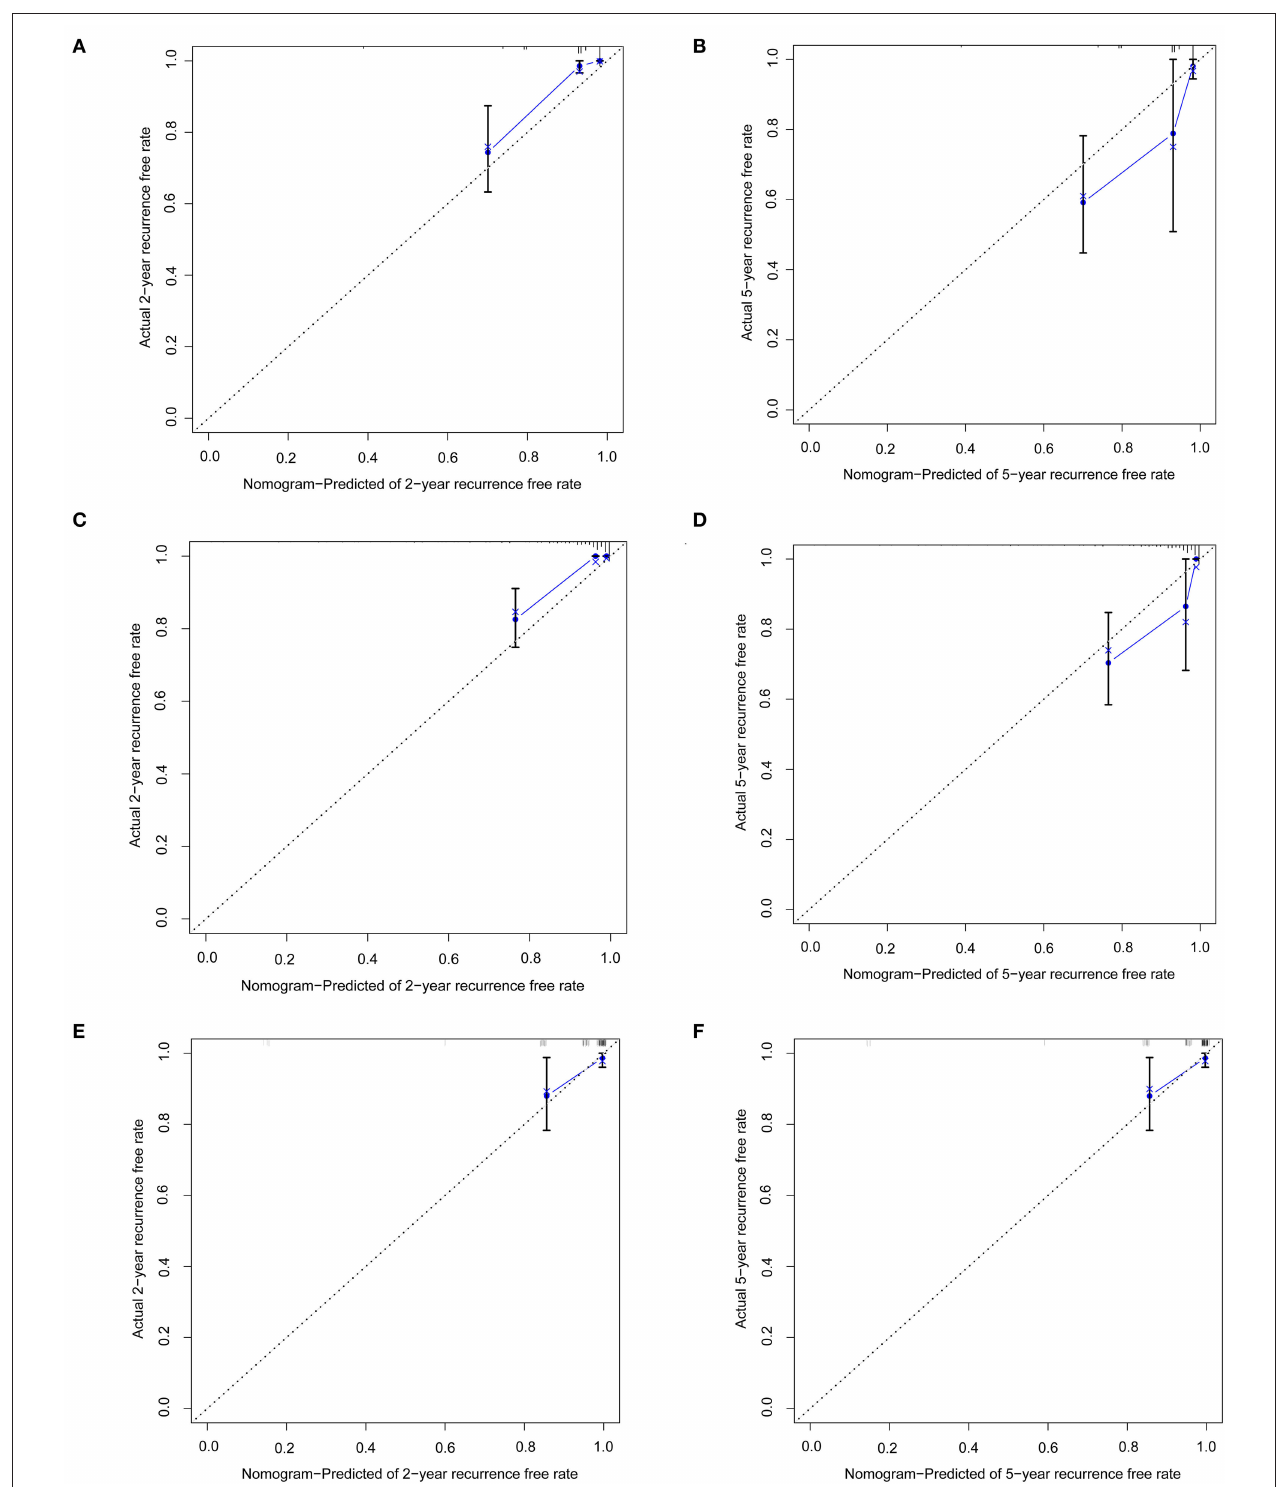
FIGURE 4 | Calibration curves represent the difference between the actual prediction (blue line) and the ideal perfect prediction (45 ◦ line). (A) 2-year recurrence free rate in the training set of nomogram 1. (B) 5-year recurrence-free rate in the training set of nomogram 1. (C) 2-year recurrence-free rate in the training set of nomogram 2. (D) 5-year recurrence-free rate in the training set of nomogram 2. (E) 2-year recurrence-free rate in the validation set of nomogram 1. (F) 5-year recurrence-free rate in the validation set of nomogram 1.